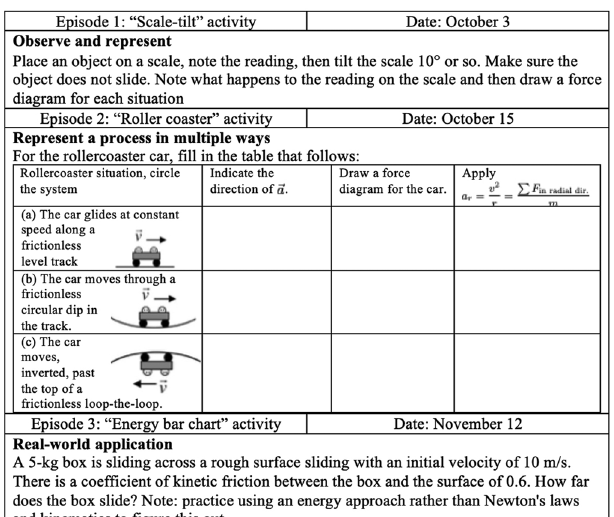
FIG. 2. The questions that students were working on for the three episodes we analyzed.